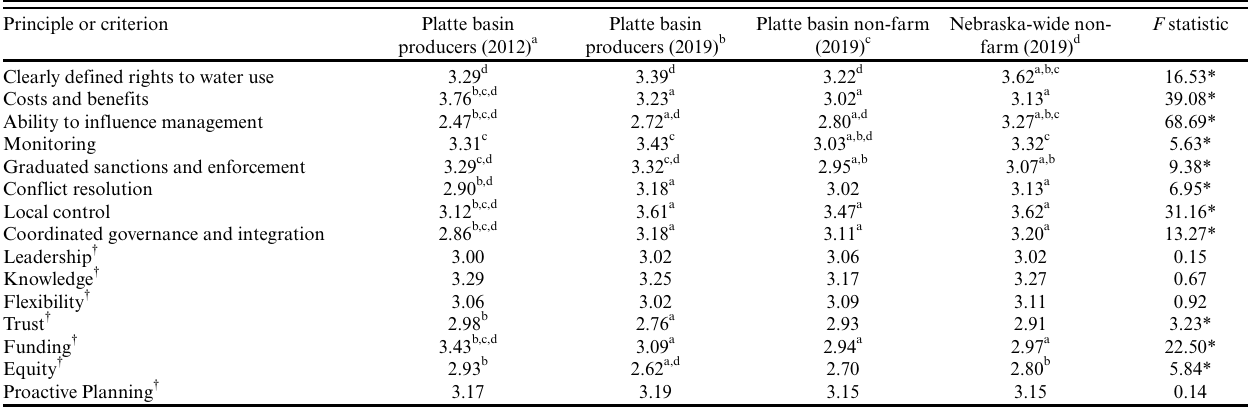
Table 3. One-way analysis of variance results for respondent group ratings of 15 water management success criteria. Values with different lowercase letters within a column are statistically different (Tukey post-hoc comparisons at P < 0.05). Principle or criterion Platte basin Platte basin Platte basin non-farm producers (2012) a producers (2019) b (2019)